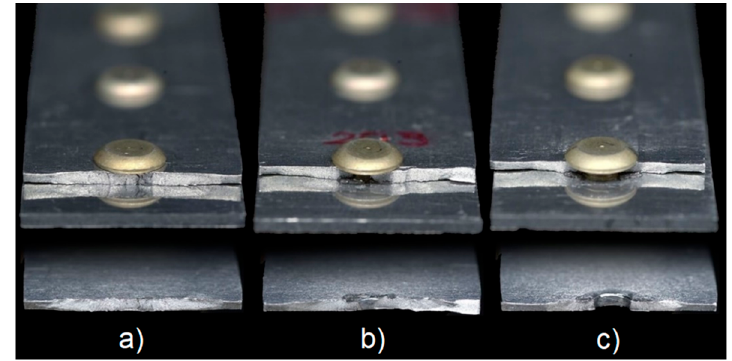
Figure 4. Crack types: in the proximity of the hole at 90 MPa ( a ) and at 120 MPa ( b ); through-hole at 160 MPa ( c ). 160 MPa ( c ).